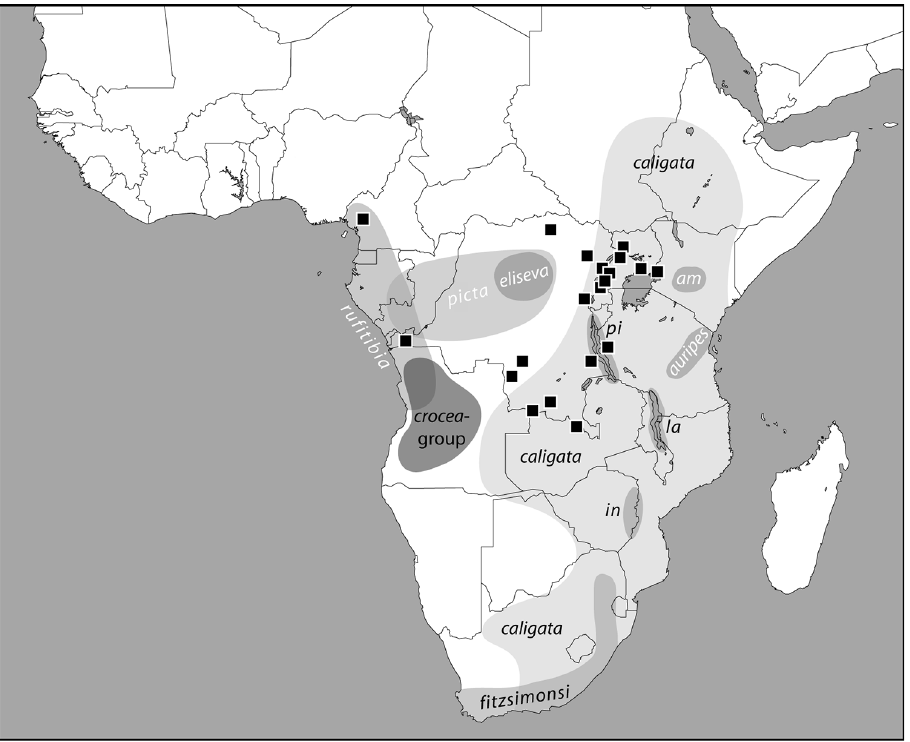
Figure 4. Distribution of the endemic crocea -group of Platycypha species and all congeneric taxa. Names of taxa that favour open habitats are in black, those tending toward forest in white (although P. rufitibia occurs on very open rivers); abbreviations: am — P. amboniensis , in — P. inyangae , la — form “lacus” of P. caligata which may represent a distinct species, pi — P. pinheyi . The rather dispersed forest species P. lacustris is shown with black squares (adapted from Dijkstra